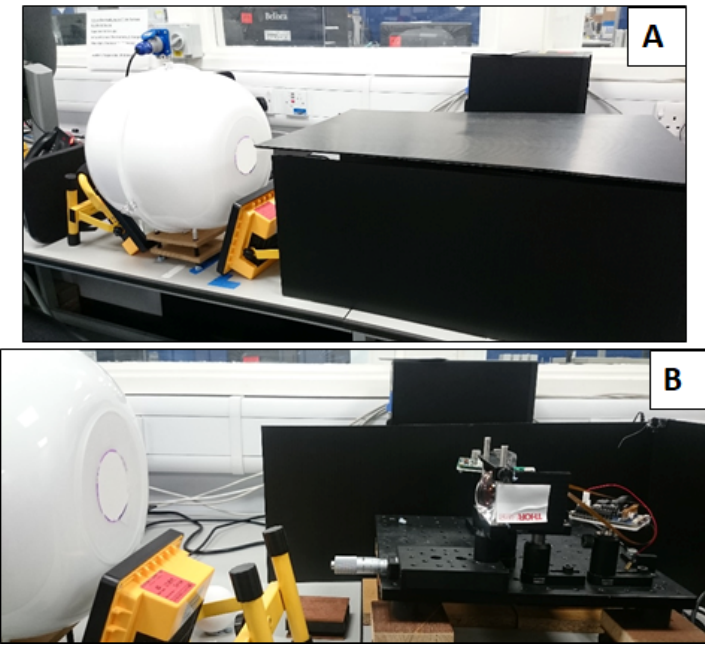
Figure 4. The current set-up of the hyperspectral imager: ( A ) displays the true set-up during image capture, with the hyperspectral imager covered by a dark box, while ( B ) displays the alignment between the sphere and the hyperspectral imager with the dark box removed.